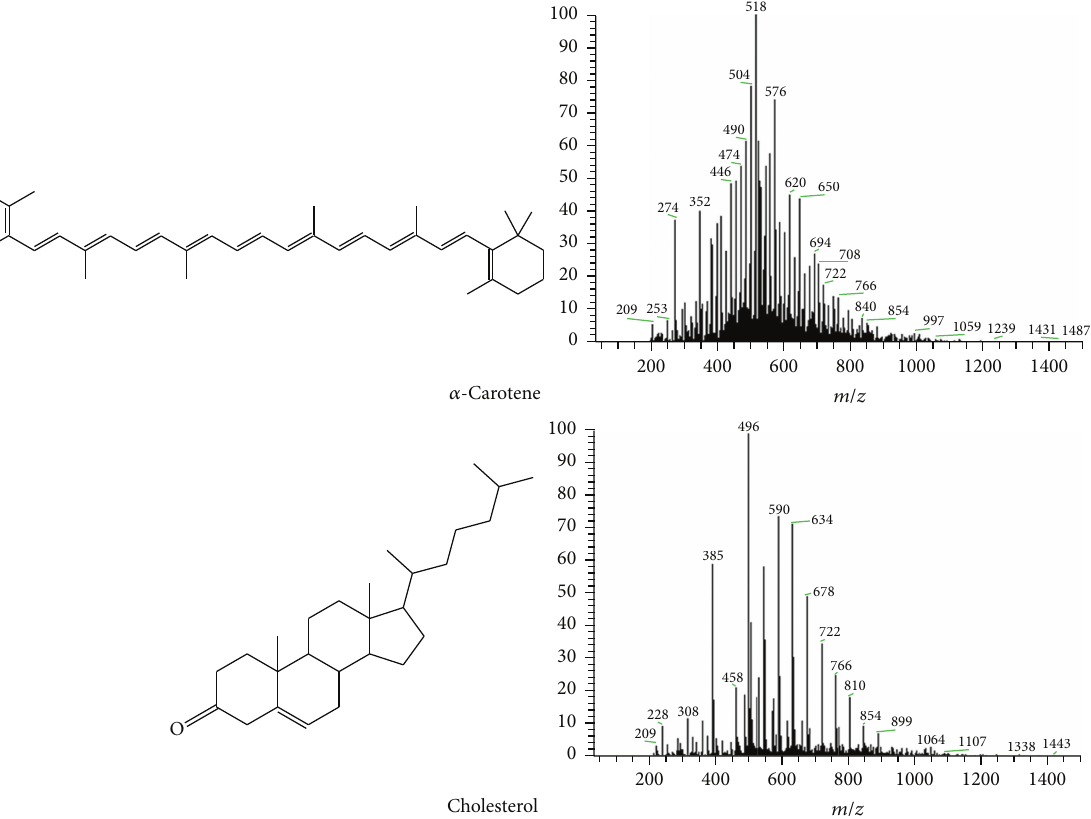
Figure 7: Spectral analysis and identification of compounds from the samples. Spectra in the NIST database match those of 𝛼 -carotene and